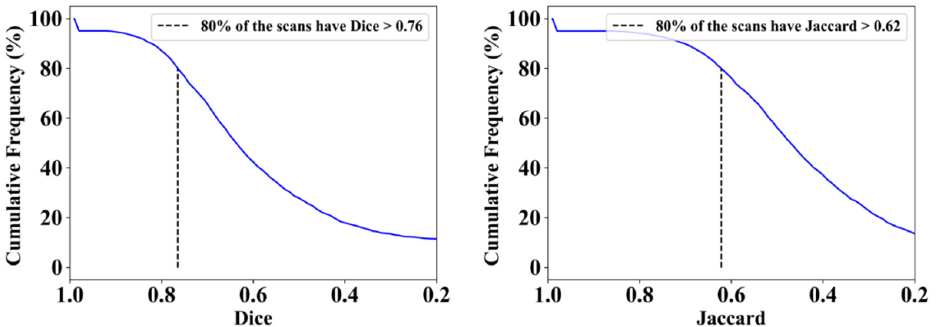
Figure 17. Cumulative frequency plot for Dice ( left ) and Jaccard ( right ) for MedSeg when computed against MD 1.